Question: Name the type of graph shown.
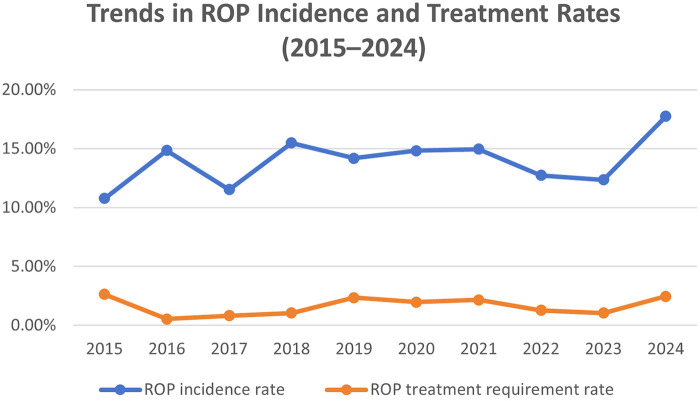
Answer: line